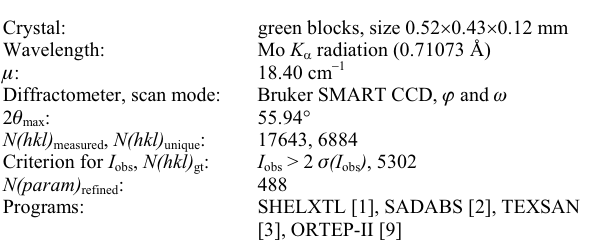
Table 1. Data collection and